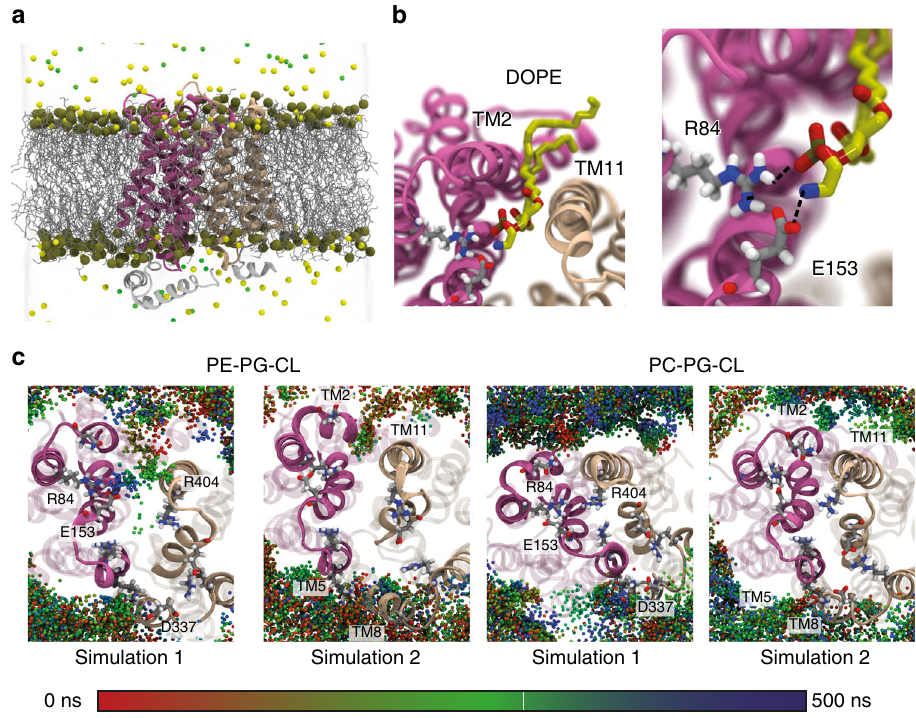
Fig. 4 MD simulations reveal that PE – protein interactions perturb the charge-relay networks. MD simulations predict speci fi c interactions between the PE headgroup and charged residues of networks 1 and 2 in XylE. a Simulation box. Representative snapshot of XylE (PDB: 4JA4) embedded in an explicit lipid bilayer and water box with 100 mM NaCl. Lipid molecules are shown in line representation colored in silver, phosphorus atom of the headgroup represented by orange spheres. Yellow and green spheres represent Na + and Cl - ions, respectively. b Representative snapshot of the close-up of network 1 interacting with the PE headgroup of the phospholipid. Polar interactions with R84 and E153 prevent network formation and steric hindrance prevents contacts of the TM2 and TM11. c Location of the phosphorus atoms of the PE/PC lipid molecule in two 500 ns trajectories in PE:PG:CL bilayers (left) and PC:PG:CL bilayers (right). The spheres are color coded: red at t = 0 ns and blue at t = 500 ns. In both simulations 1 and 2, PE lipids wedge between the helices (more so in simulation 1), but no lipid – protein interaction is observed in PC bilayers. In simulation 1, direct interactions with residues R84, E153 and R404 of network 1 are